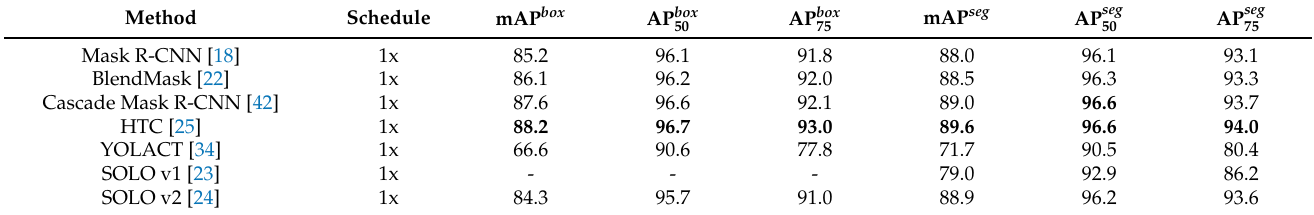
Table 11. Instance segmentation benchmark on SCD. All models were trained with the image scale of [800, 1333]. We used ResNet-50 pretrained on ImageNet dataset as a backbone for all